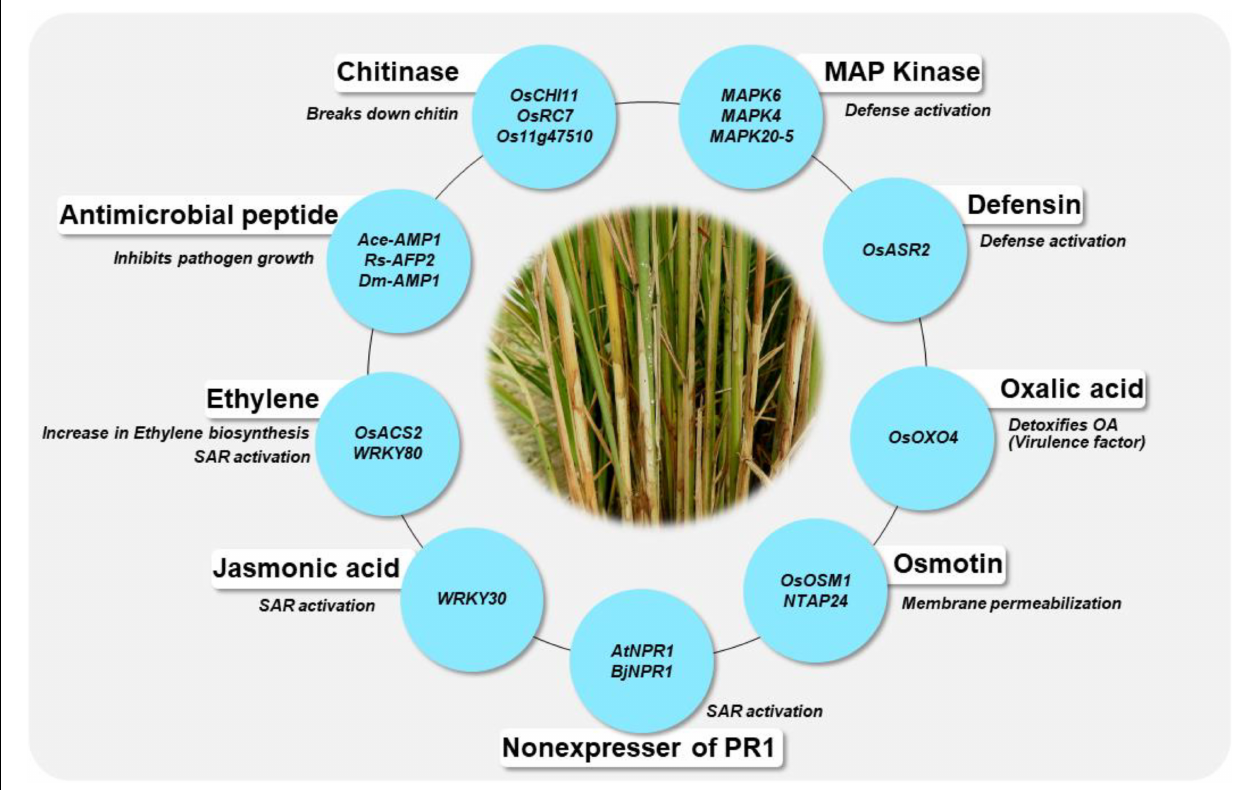
FIGURE 5 | Genes are being utilized for the development of transgenics and their mode of action in conferring resistance to sheath blight disease of rice. The blue circle indicates the genes, the details of their mode of action are given in Table 5